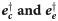
Trajectories of eo, e†, REC, e†, ec†andee† in a Siler mortality change model with different rates of decline.